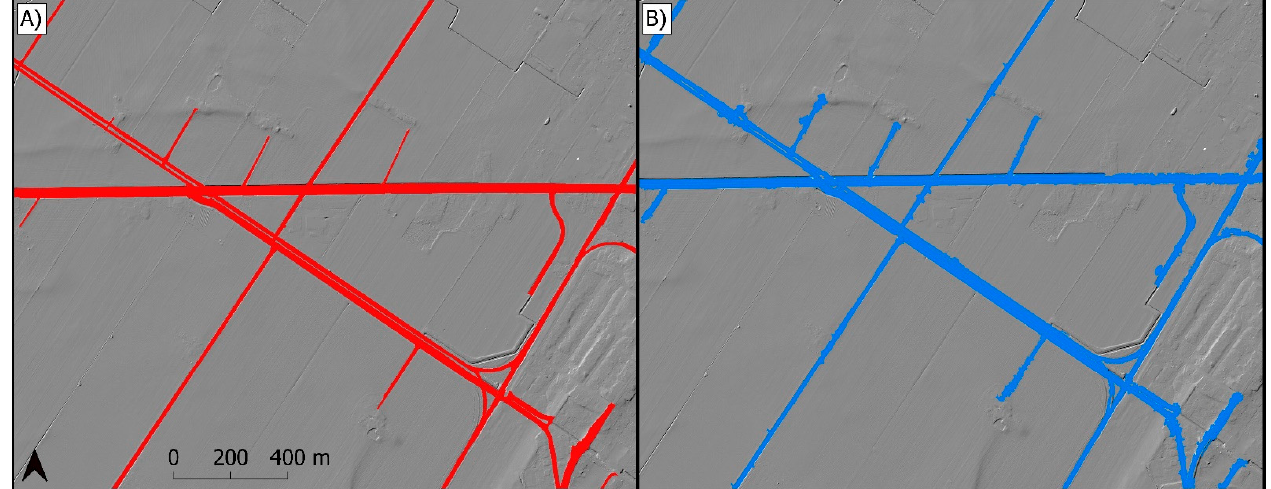
Figure 4. ( A ) The digitized reference embankments of McGregor Creek Test Site 1; ( B ) The embankments classified by the algorithm. Figure 5 demonstrates the tool’s ability to identify ditch-lined embankments. Beyond Zones 1 and 2, corresponding to seed points and the level embankment surface width, respectively, most of the identified embankment region maps to Zone 3 cells.